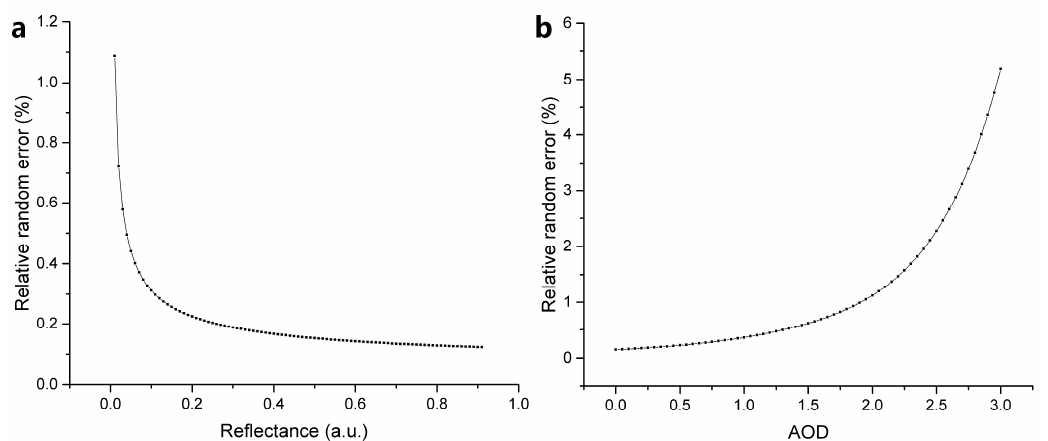
Figure 7. The independent effects of reflectance and AOD on the performance of the CO 2 -IPDA. ( a ) shows Reflectance and ( b ) panel shows AOD.